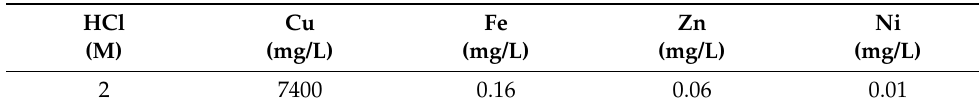
Table 6. Analysis of the stripped liquor in one